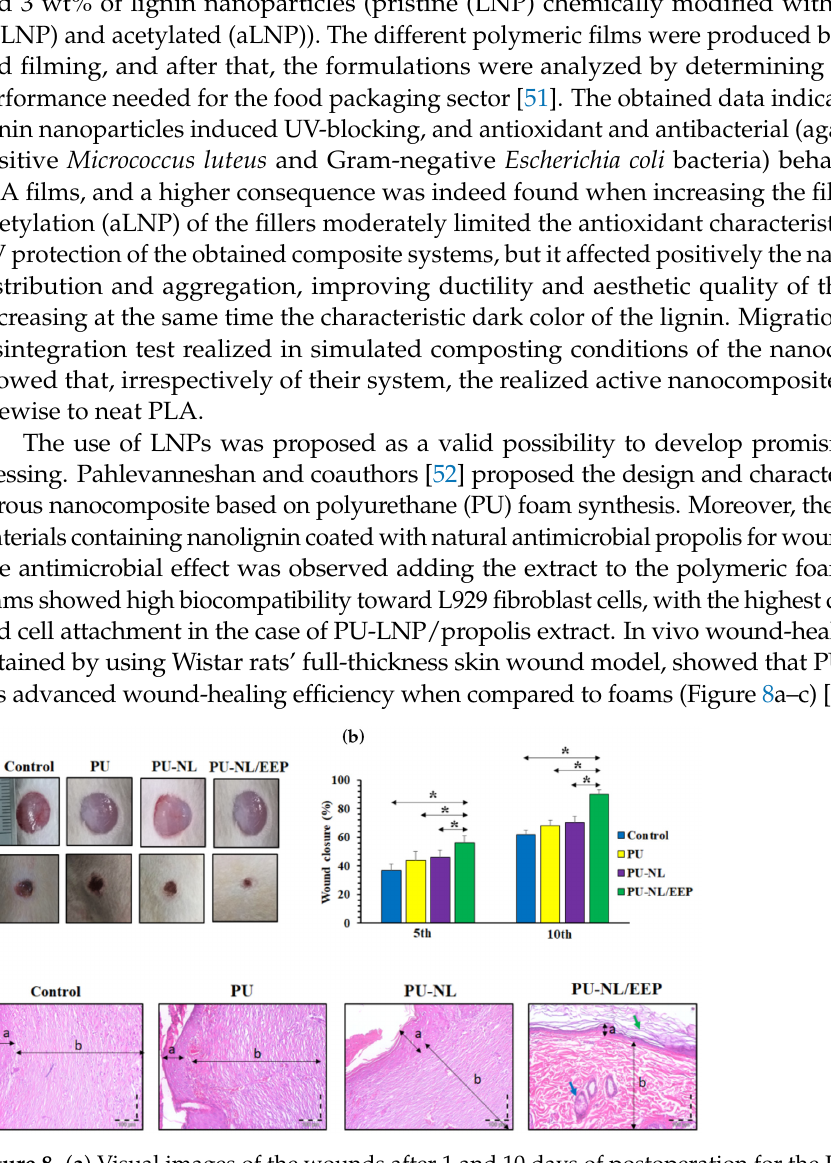
Figure 8. ( a ) Visual images of the wounds after 1 and 10 days of postoperation for the PU, PU-LNP, and PU-LNP/EEP groups. ( b ) Histograms of the wound closure for PU, PU-LNP, and PU-LNP/EEP groups. The data are expressed as mean ± standard deviation, (n = 8, *: p < 0.05, ns: not significant). ( c ) H&E-stained sections of skin specimens from the wound site of PU, PU-LNP, and PU-LNP/EEP groups. Arrows (a and b letters) designate the epidermis and dermis layers, respectively. Green and blue arrows indicate the keratin layer and sebaceous gland, respectively. Reprinted from Ref. [52]. Copyright 2021 MDPI